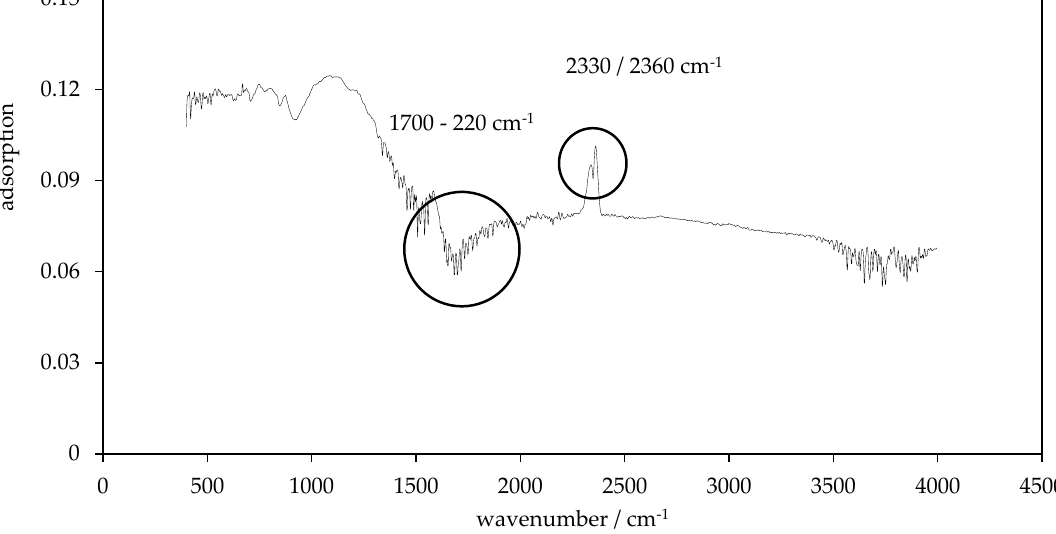
Figure 10. FTIR spectrum of char P900-240-2.